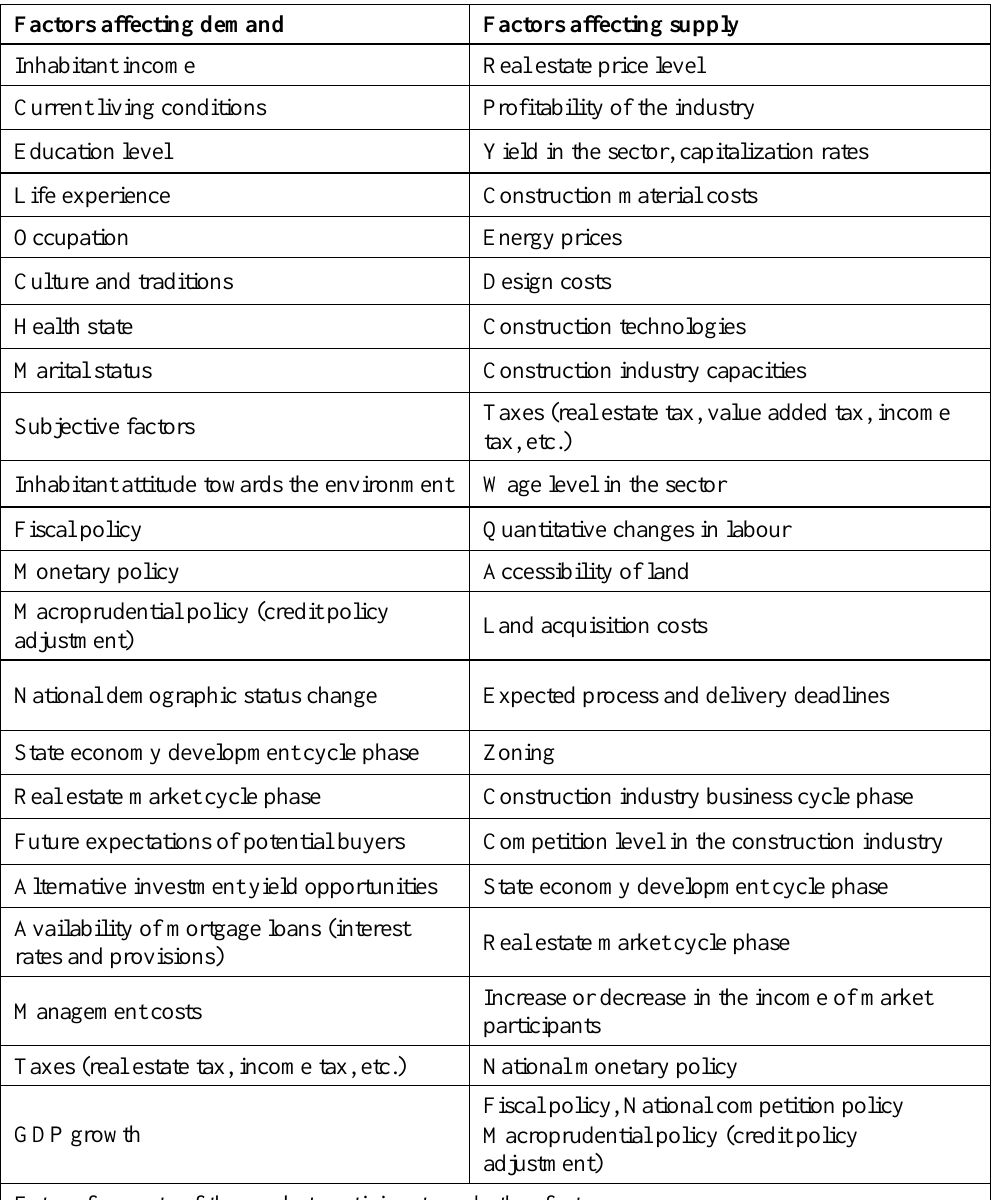
Table 1. Real estate market development influencing the supply and demand factors – model (table made by